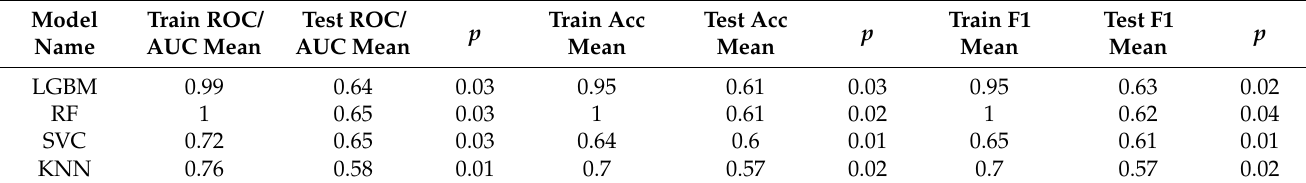
Table 4. Predictive performance of four models.